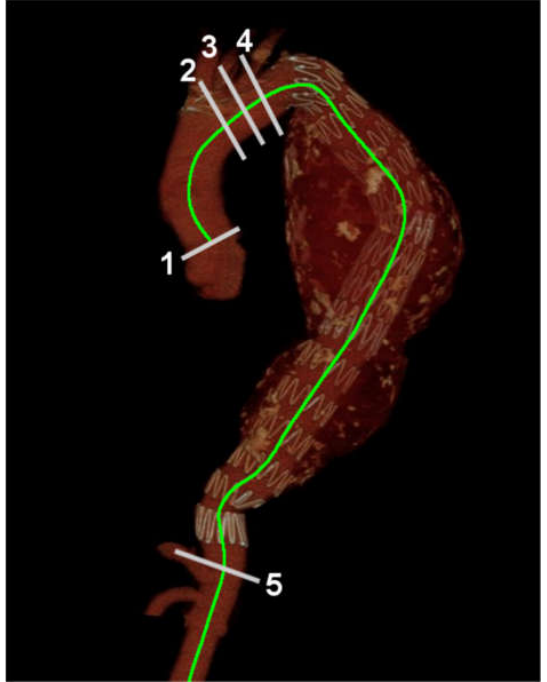
Figure 1. Measuring aortic length. 1, Sinotubular junction (STJ); 2, innominate artery (INA); 3, left common carotid artery (LCCA); 4, left subclavian artery (LSCA); 5, celiac artery (CA). The aortic